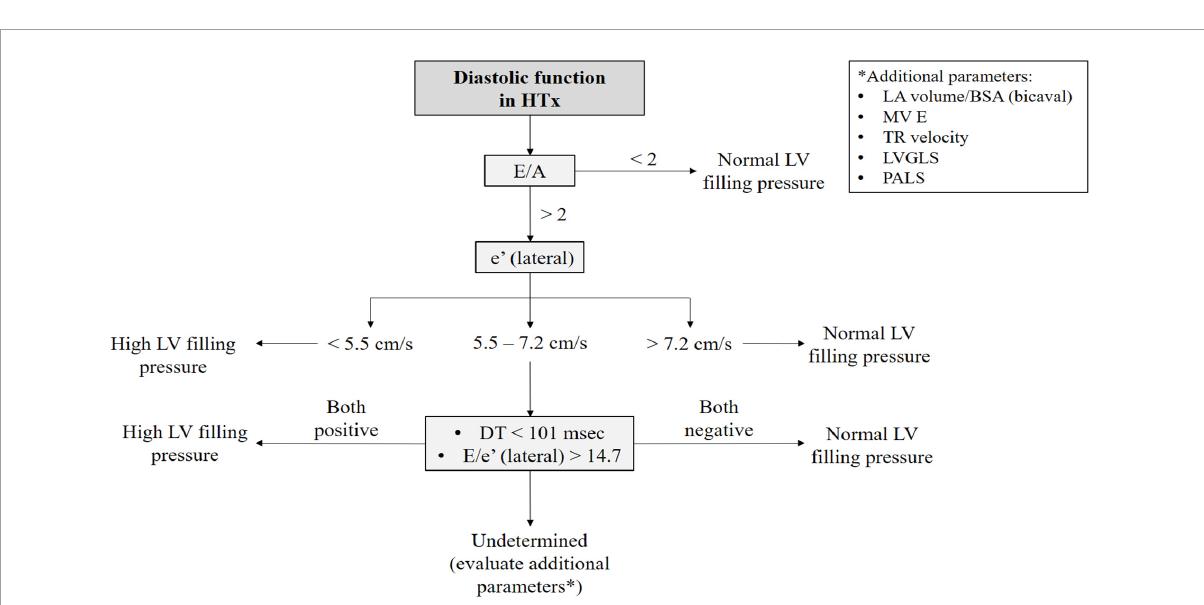
FIGURE3 Proposed algorithm to evaluate diastolic function in heart transplant patients. The first step in the evaluation of diastolic function in HTx is assessing mitral inflow velocities. In the case of an E/A ratio < 2 high LV filling pressure can be fairly excluded. On the other hand, if the E/A ratio > 2, it is useful to evaluate TDI-derived velocities. However, when their values lie in a gray zone, DT and E/e’ ratio should be considered. If these latter two indexes together cannot exclude high LV filling pressure, additional parameters should be used, such as LAVi (in the case of bicaval technique), LA strain, and LV-GLS and TR velocity. This is the diagnostic algorithm proposed by our center, based on the values derived from the study by Ingvarsson et al. (5). BSA: body mass index; DT: deceleration time; HTx: heart transplantation; LA: left atrial; LAVI: left atrial volume index; LV: left ventricular; LVGLS: left ventricular global longitudinal strain; MV: mitral valve; PALS: peak atrial longitudinal strain; TR: tricuspid